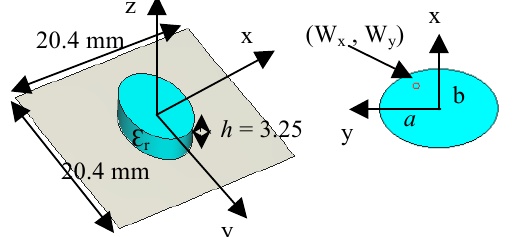
Figure 1: Geometry of a single DRA element on a ground plane.